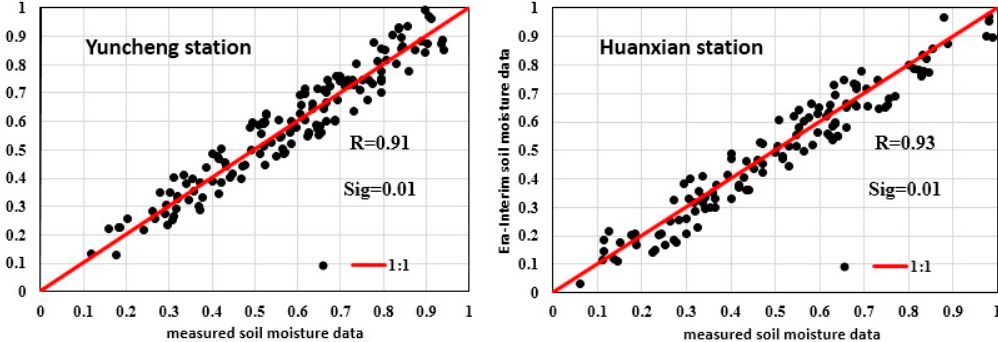
Figure 8. Comparison between the ERA-Interim soil moisture data and observed soil moisture data from 1990 to 2014: The x-axis represents the measured soil moisture data, while the Y-axis represents the ERA-Interim soil moisture data, valid for the period from 1990 to 2014.